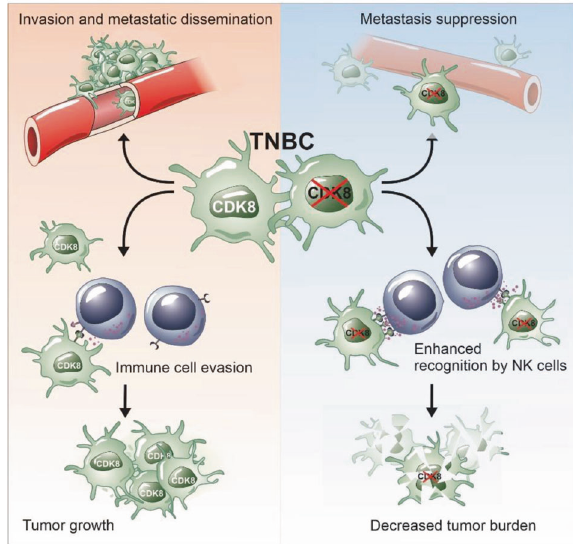
Fig. 7 CDK8 controls metastatic properties of TNBC cells and drives NK-cell immune evasion. CDK8 in TNBC drives invasion and metastatic dissemination of tumor cells and immune evasion (left box). Loss of CDK8 in tumor cells on the one hand, dampens invasiveness and pro-metastatic behavior of tumor cells and on the other hand, enhances recognition by NK cells, thereby decreasing tumor burden (right